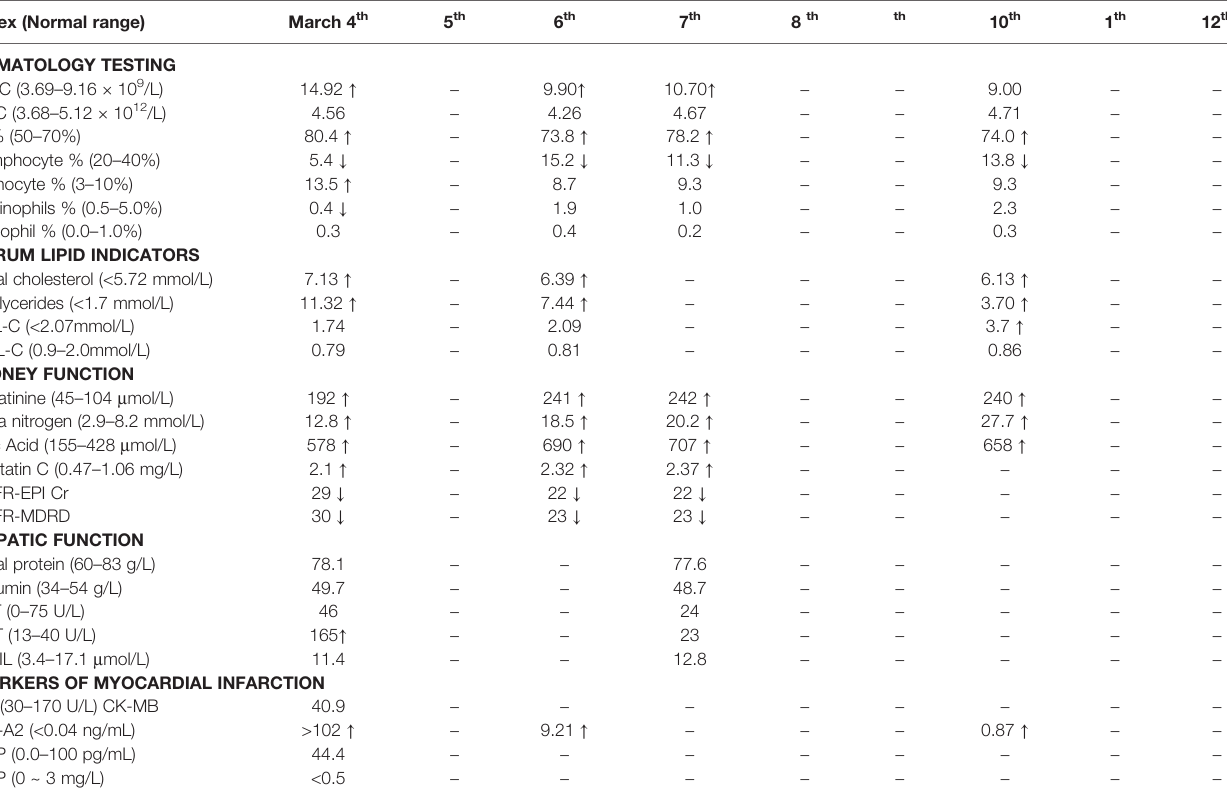
TABLE 1 | Results of main laboratory test and history.